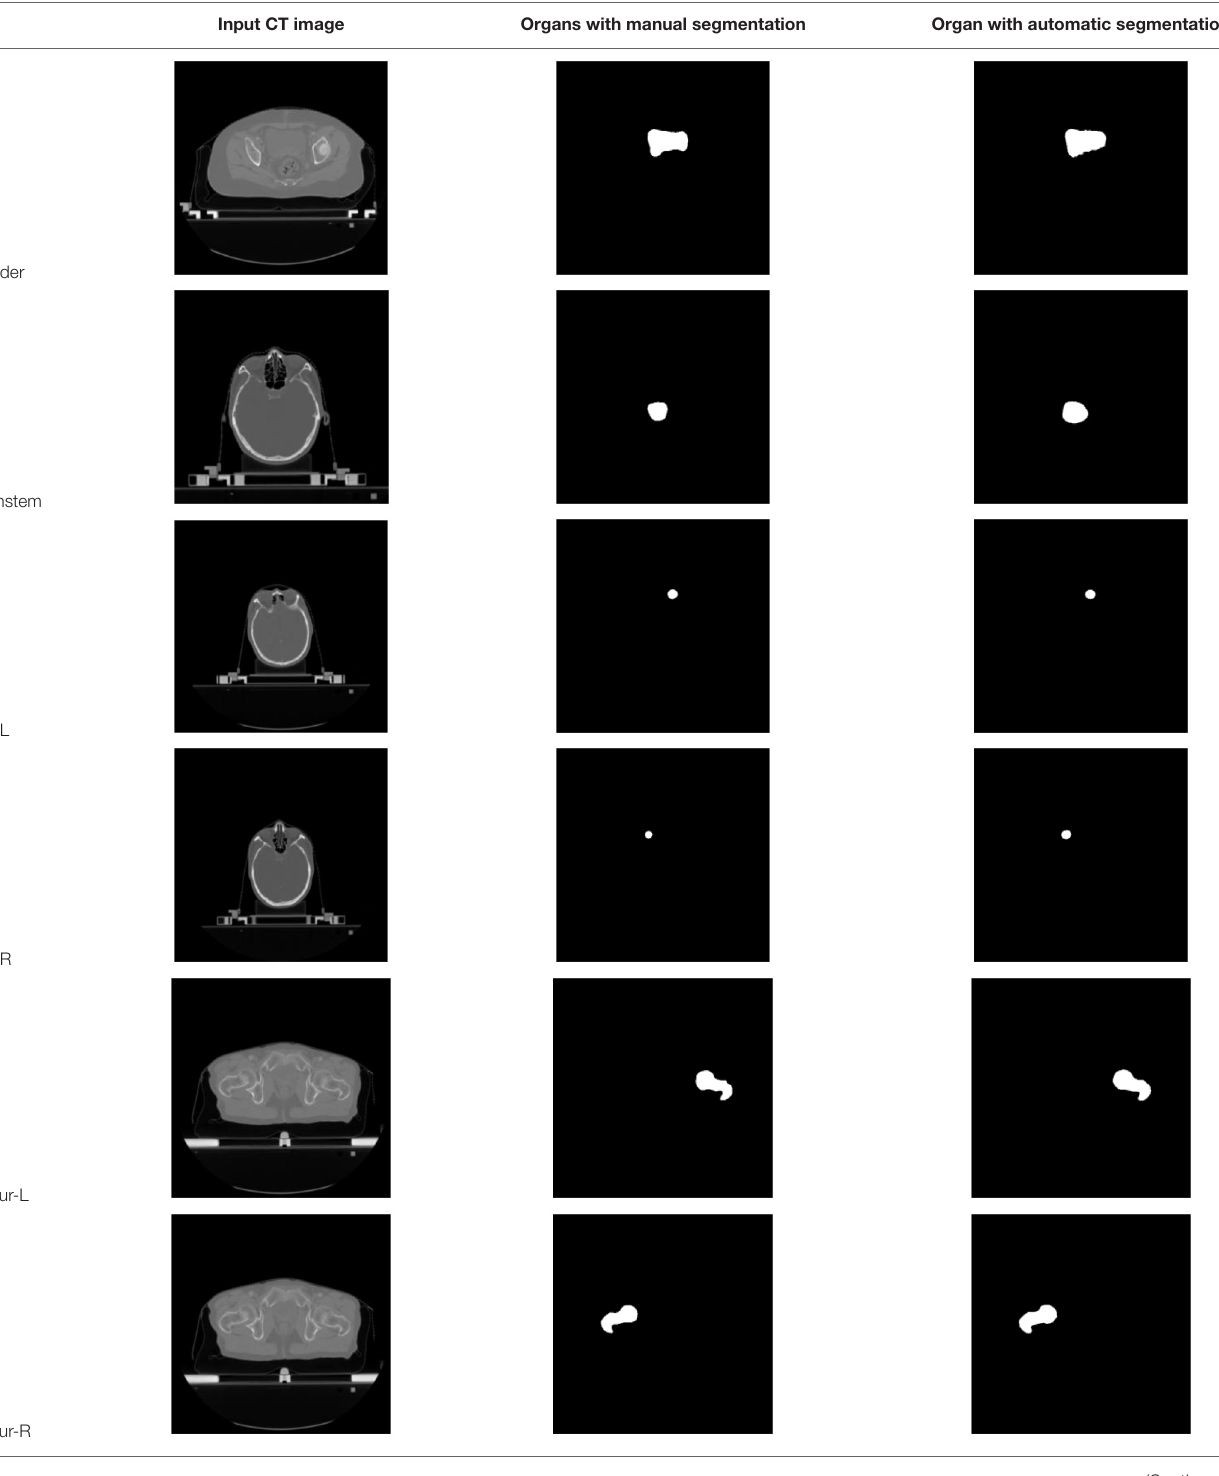
TABLE 1 | The result of manual and automatic organ